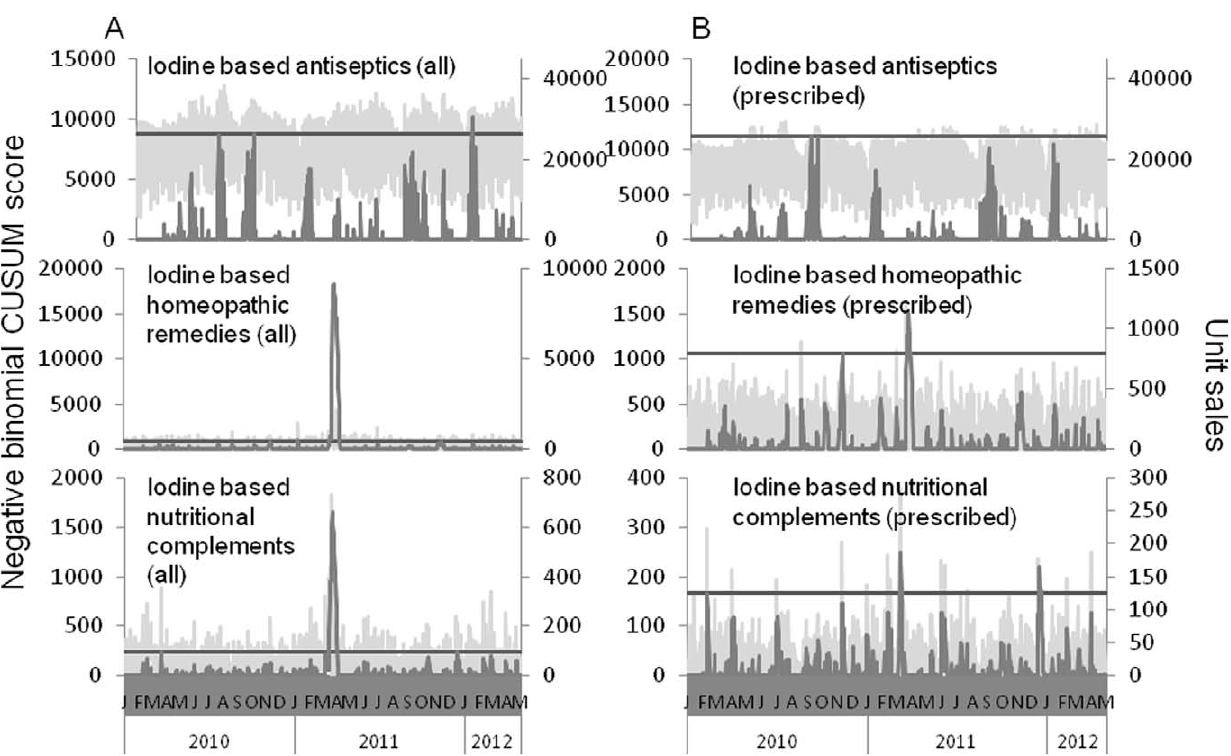
Figure 2. Dark gray lines stand for negative binomial CUSUM score for unit sales of Iodine based antiseptics, homeopathic remedies and nutritional complements (from top to bottom). The straight lines on the plots illustrate the threshold for the CUSUM score, defined as the maximum value of the CUSUM score in 2010. An increase in the CUSUM score indicates a strong positive deviation from the normal trend. Light gray lines represent unit sales volumes. Panel A shows results for all type of sales while panel B only shows sales with a physician prescription.